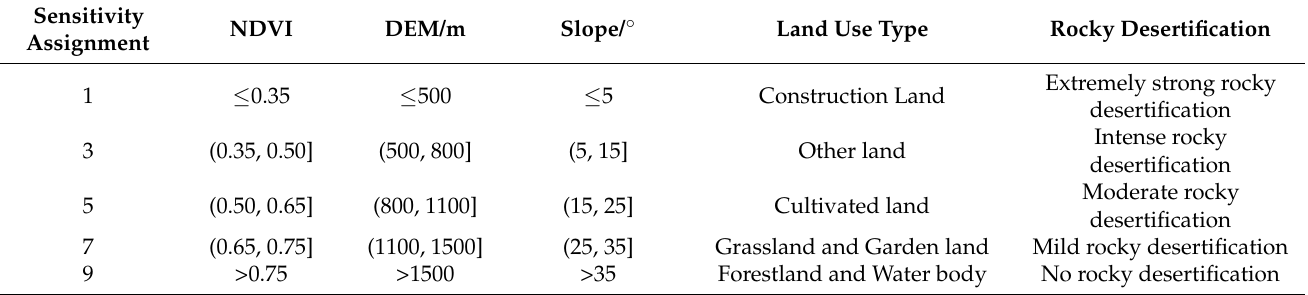
Table 2. Ecological environment sensitivity the evaluation factor classifications and